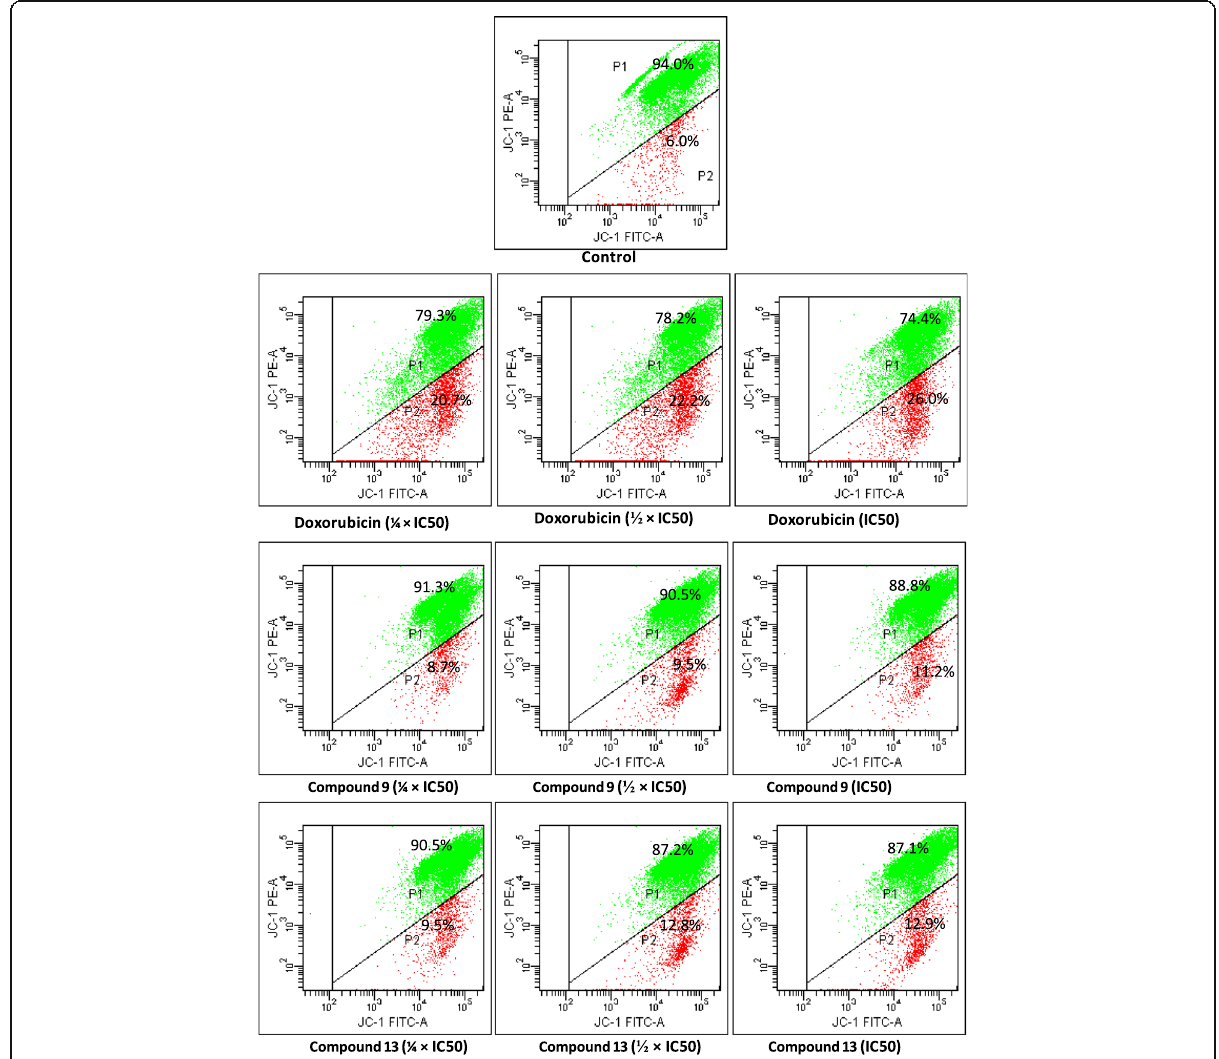
Fig. 4 Effects of thonningiol (9), seputhecarpan D (13) and doxorubicin on MMP in MCF-7 cells for 72 h. IC 50 : 0.36 μ M (thonningiol), 9.78 μ M (seputhecarpan D) and 0.35 μ M (doxorubicin). P1: cells with intact MMP; P2: cells with altered